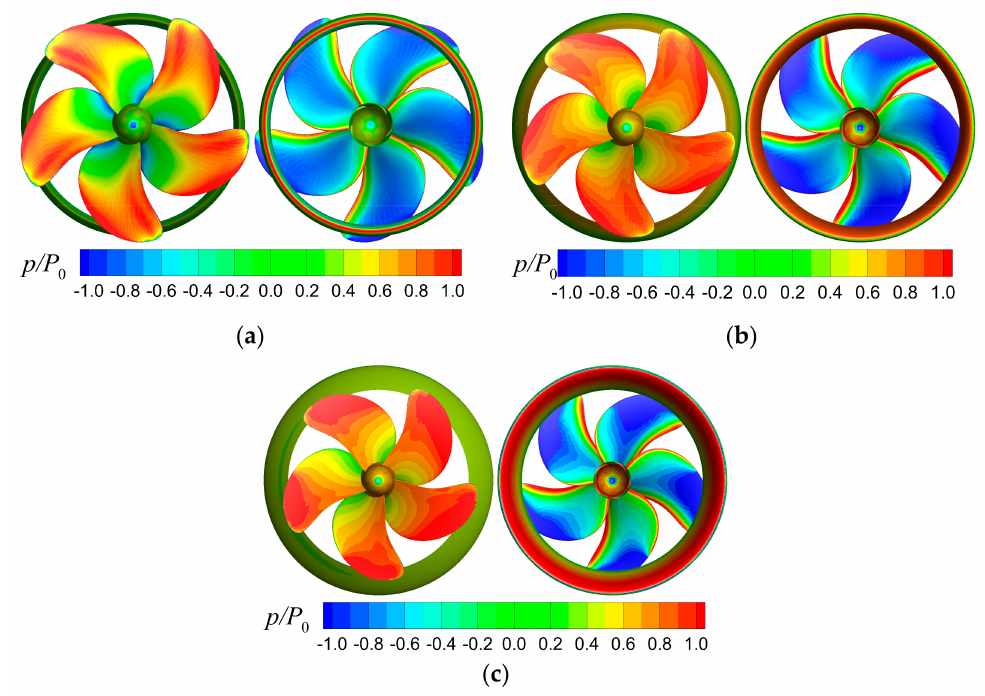
Figure 11. Comparison of the pressure distributions on the nozzle, pressure side (left) and suction side (right) for D N = 0.9 D . ( a ) θ = 0 ◦ , ( b ) θ = 10 ◦ , ( c ) θ = 20 ◦